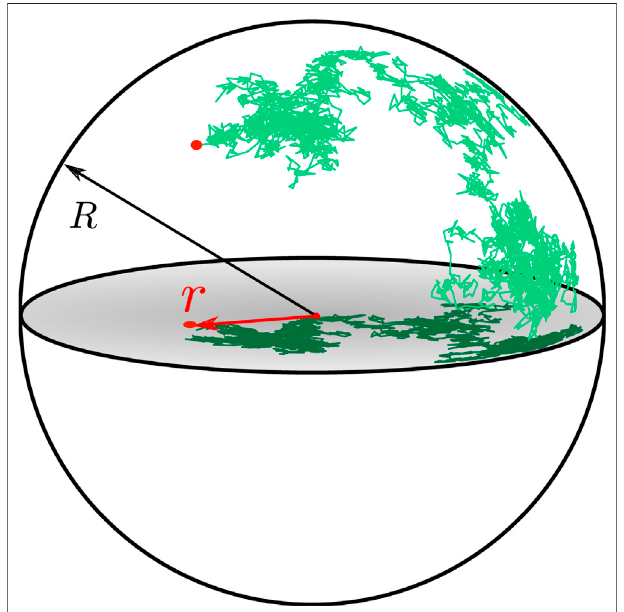
FIGURE 4 | Projection on an equatorial plane of the Brownian motion which takes place over the surface of a sphere of radius R . The polar radial coordinate of the particle r is measured on the